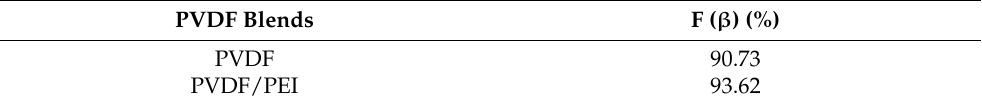
Table 3. Spectral parameters, beta-content, and pure PVDF and its blends.